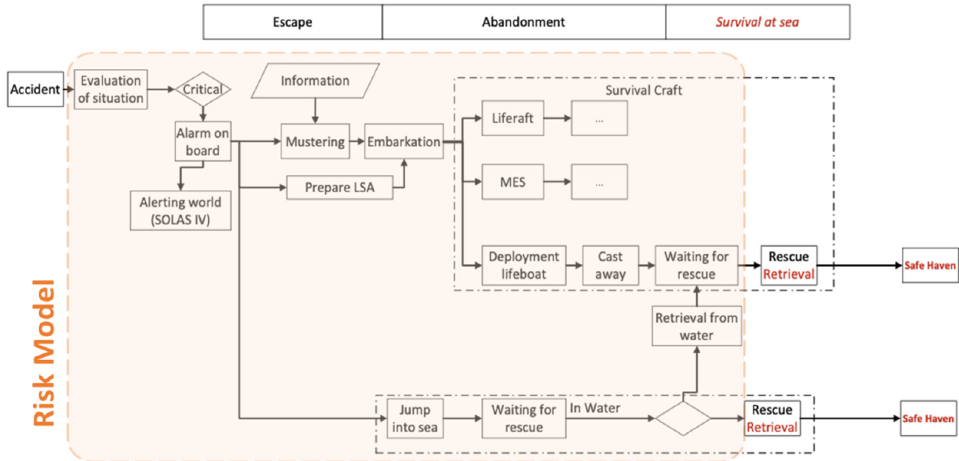
Figure 2. Event sequence in emergency cases which highlights the risk model focus, adapted from SSE 4/3 (2017) [6].